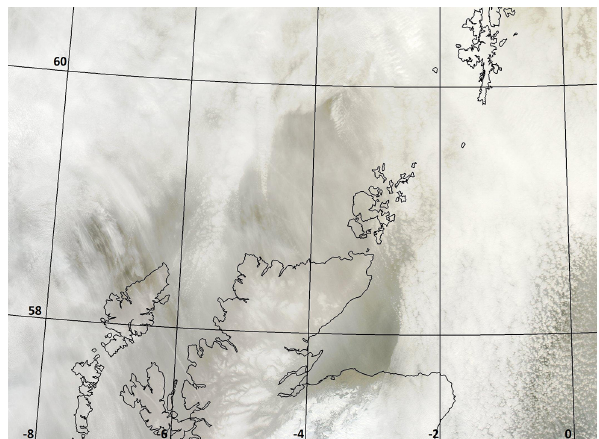
Figure 1. A high-resolution composite MODIS image of the semi- transparent cirrus case that occurred on 25 January 2010 located over north-east Scotland. The latitude and longitude grid is super- imposed on the image showing latitude 58 to 60 ◦ (left side) and longitude − 8 to 0 ◦ (bottom). The composite image was formed by combining the MODIS red, green and blue channels to obtain the closest “true” colour image. The image is from the NERC Satel- lite Receiving Station, Dundee University, Scotland (http://www.